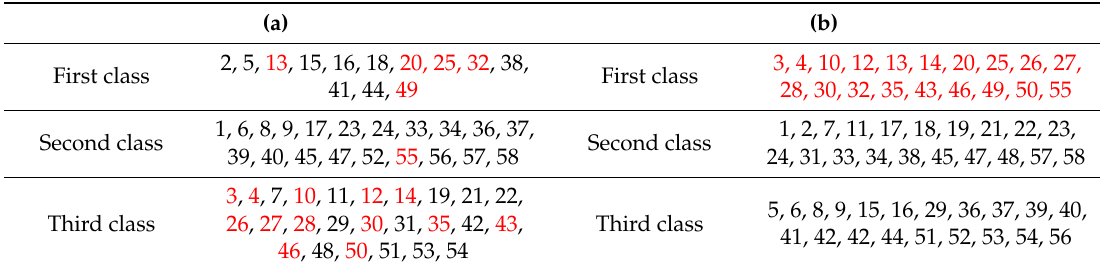
Table 3. Comparison of classification results by (a) calculating the C p , and (b) using the